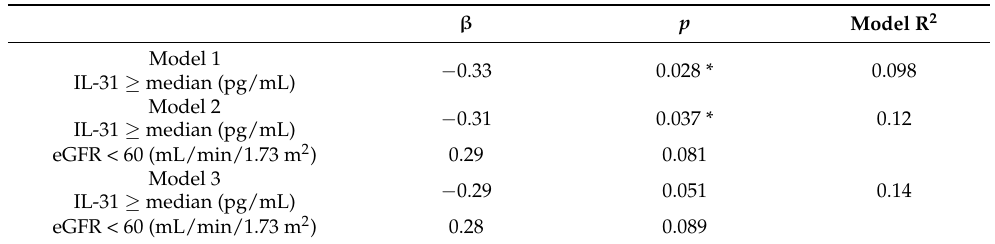
Table 5. Multivariate-adjusted regression analysis of predictors of proteinuria in different models including serum IL-31 in IgAN. β p Model R